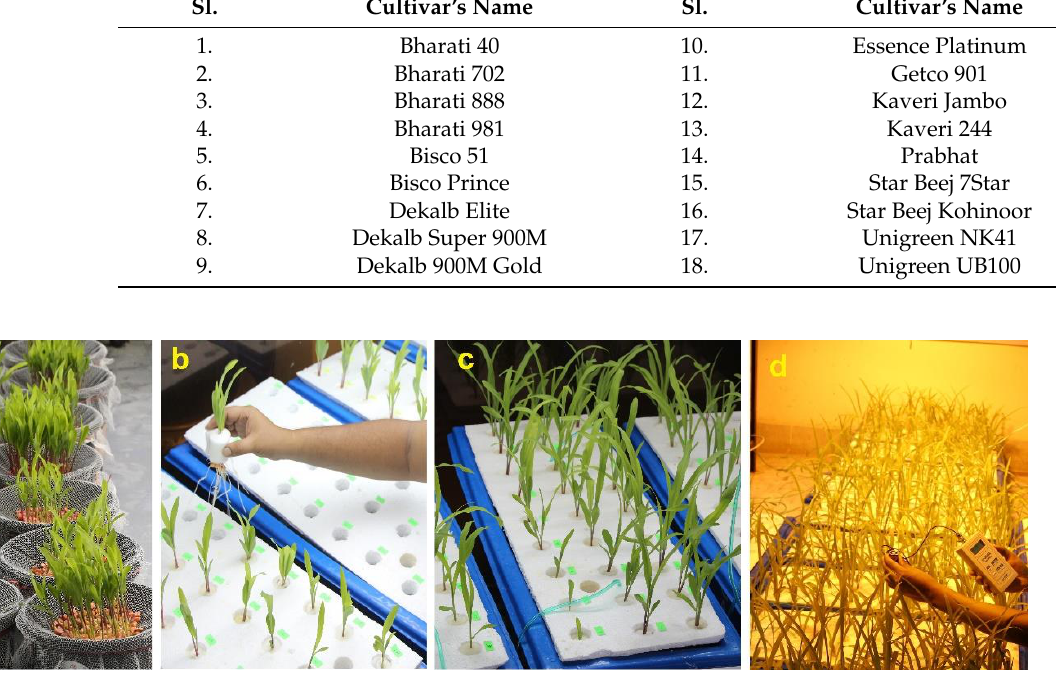
Table 1. List of 18 hybrid maize cultivars used in the study for screening of salt tolerance. Sl.